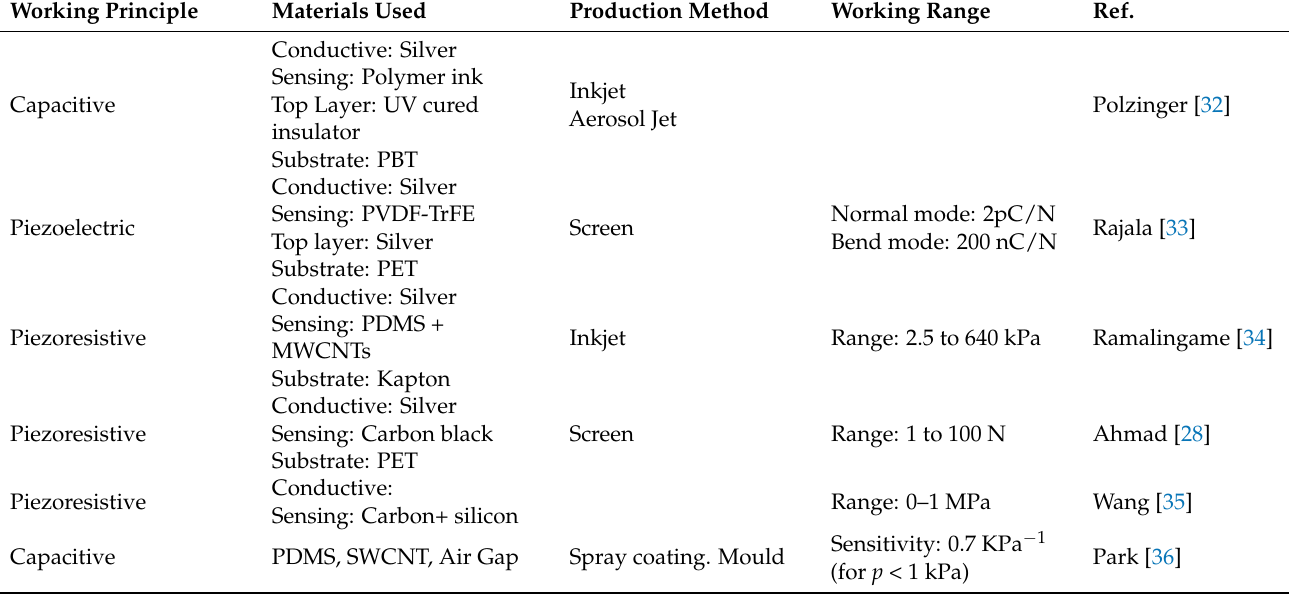
Table 1. Overview of printed pressure and force sensors along with materials used, printing tech- niques, and working